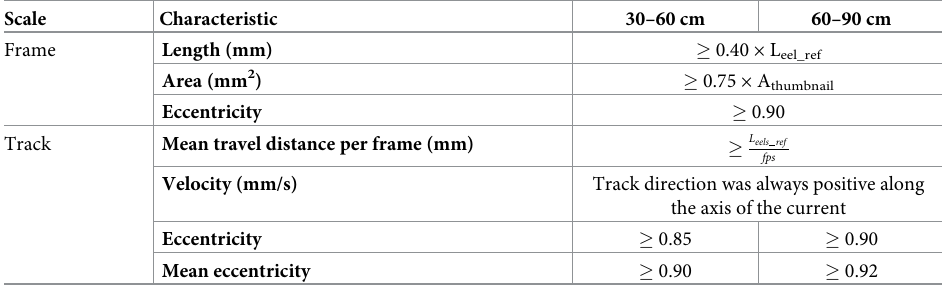
Table 2. Decision rules for characteristics used to distinguish an eel from another object as a function of the length interval of the eel population. Scale